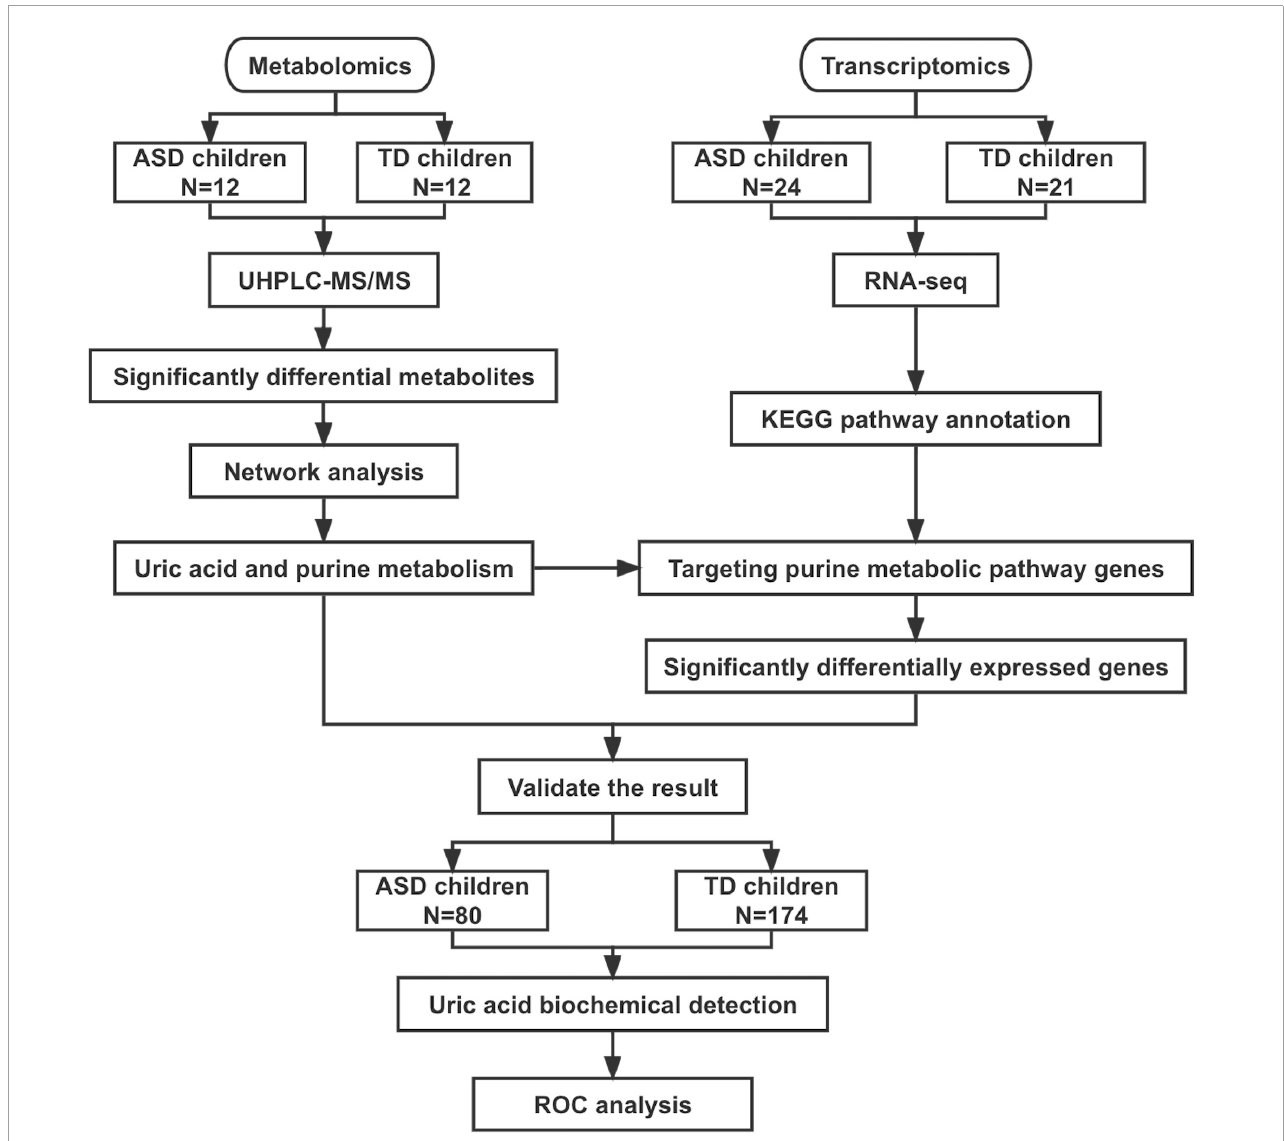
FIGURE1 Flowchart of this study. ASD, autism spectrum disorder; TD, typically developing; UHPLC-MS/MS, ultra-high-performance liquid chromatography mass spectrometry; ROC, receiver operating characteristic